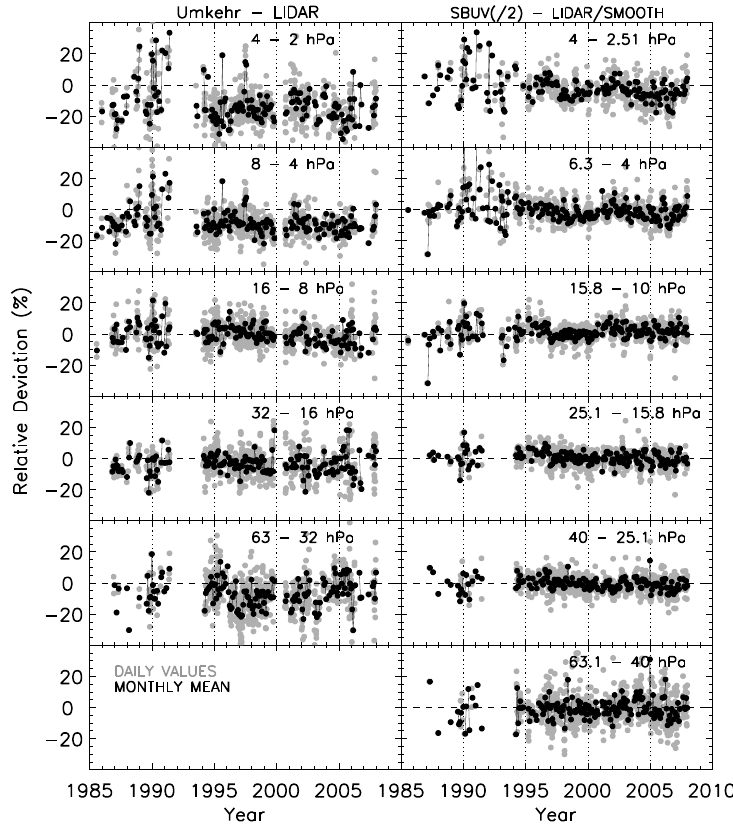
Fig. 4. Same as Fig. 3, but for Umkehr with lidar (left panel) and for SBUV(/2) with lidar convolved using SBUV(/2) ozone averaging kernels (right panel).